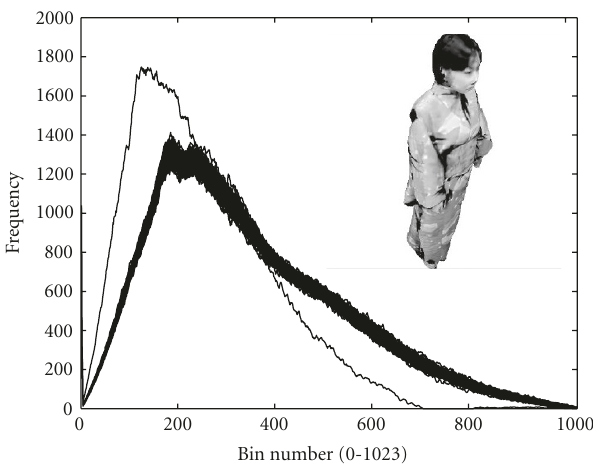
Figure 2: Thirty histograms for the same 3D model (shown on the upper side) using the original shape distribution [24]. Generated histograms have some deviation even for the same 3D model.